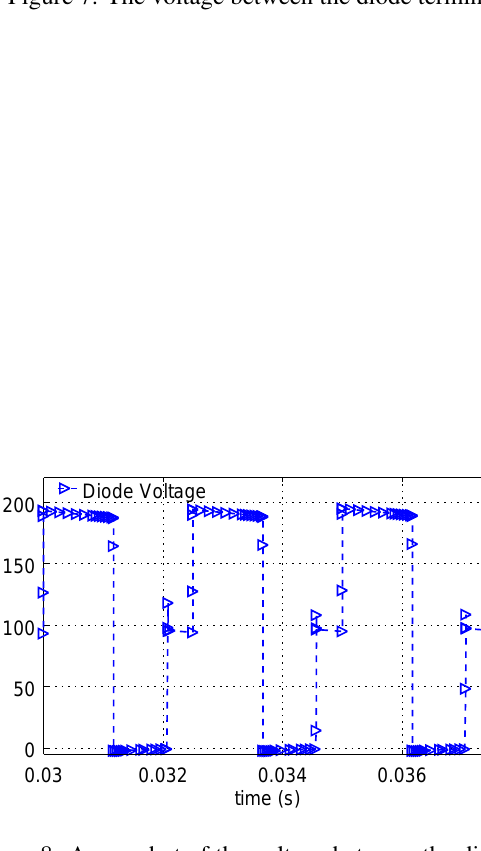
Figure 8: A snapshot of the voltage between the diode ter- minals